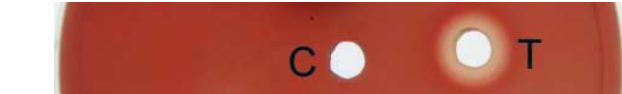
Figure 1. Hemolytic activity of the crude toxin on blood agar plate. C: control (PBS buffer, pH-7.4); T: crude